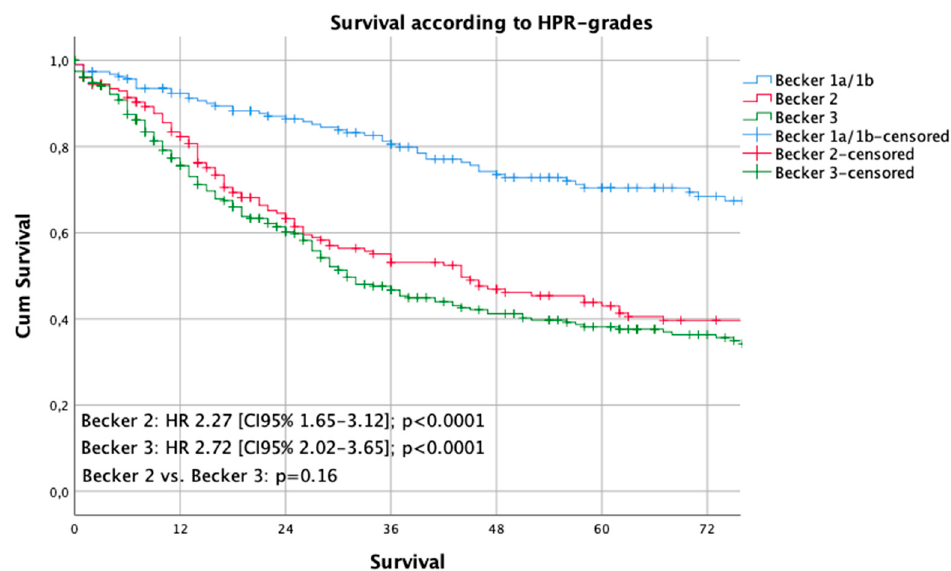
Figure 1. Survival curves according to histopathologic regression (HPR). The Kaplan-Meier method and the log-rank test were used to compare the estimated survival by histopathologic responders and non-responders.